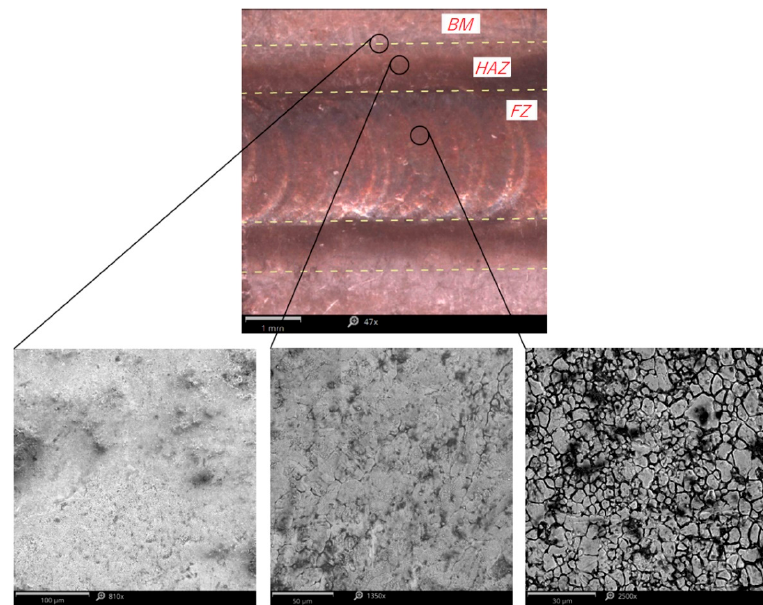
Figure 2. View of the weld face and SEM micrographs of the joint